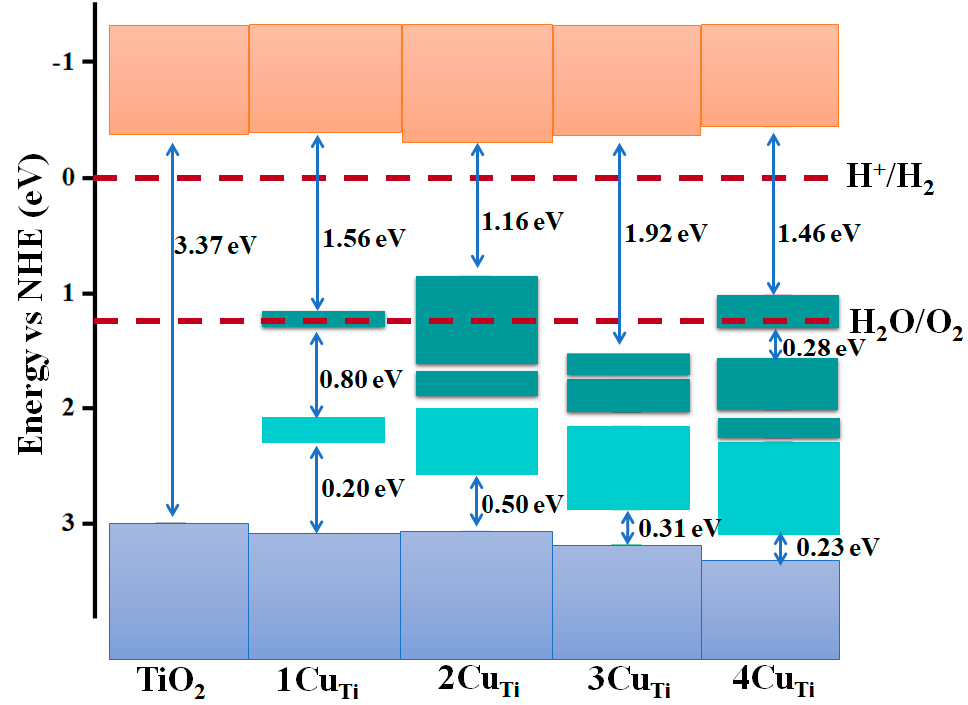
Figure 5. The band edge position of the pristine and Cu-doped TiO 2 configurations with regards to reduction and oxidation potentials of water. The CBMs and VBMs are designated with orange and light blue regions, respectively, while the intermediate energy bands are identified with broad light and dark green sections.